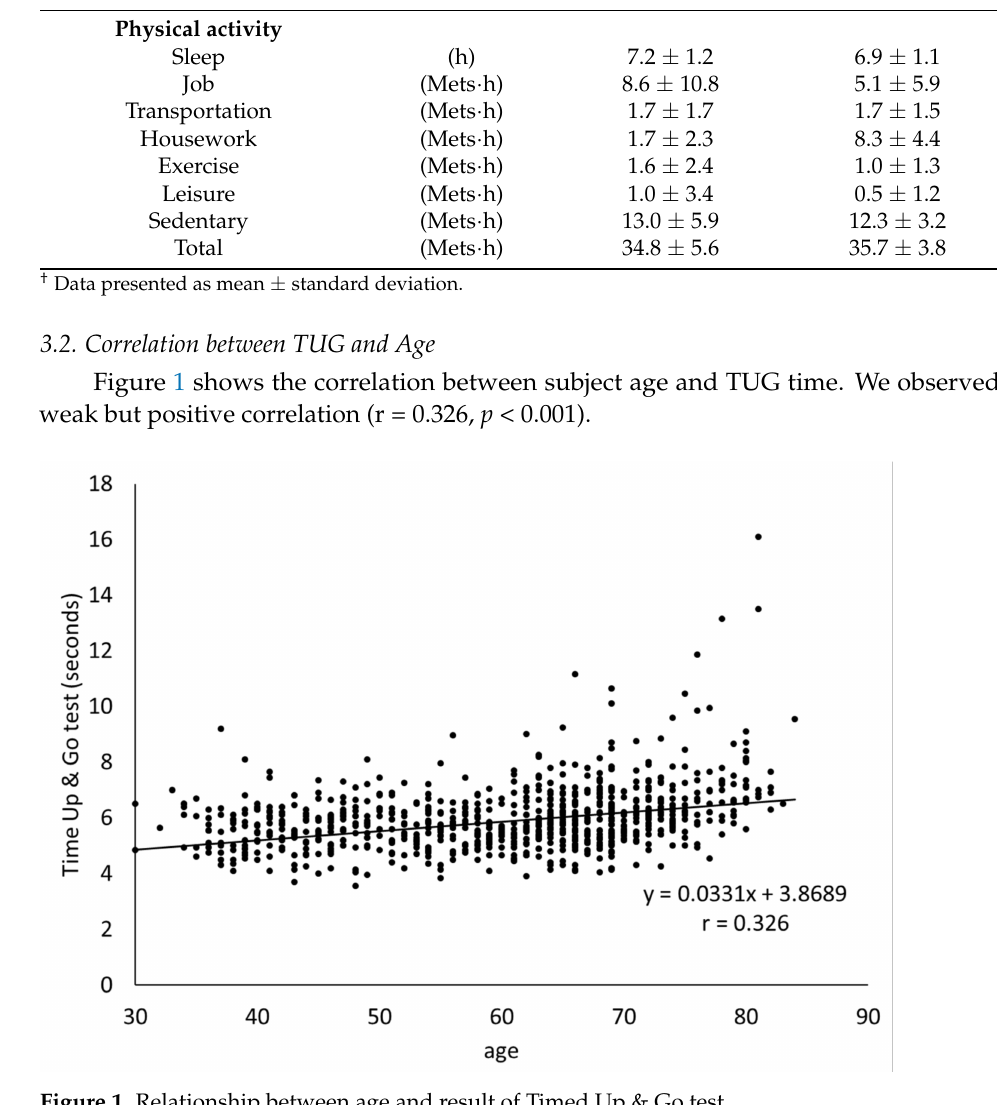
Figure 1. Relationship between age and result of Timed Up & Go